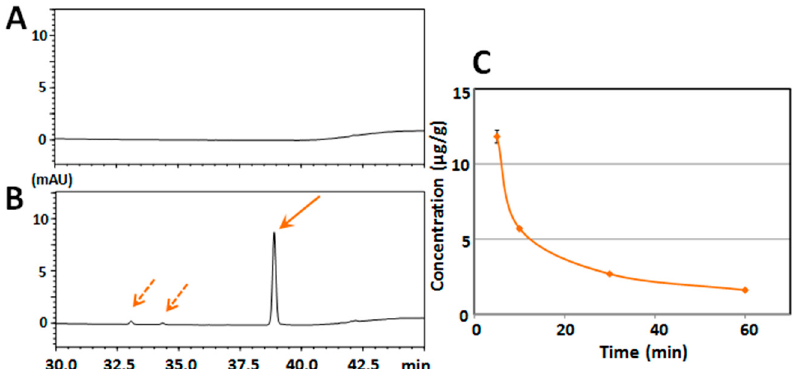
Figure 3. ( A ) HPLC chromatogram of brain tissue from vehicle-treated mouse; and ( B ) HPLC chromatogram of brain tissue from mice treated i.p. with HMF. Solid arrow is HMF and dashed arrows are putative metabolites of HMF; ( C ) Time-course of the brain concentration profiles of HMF following i.p. administration. Values are the means ± SEM.